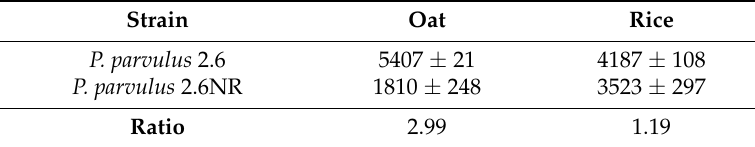
Table 2. Viscosity (cP) determined at 40 rpm for 30 s of the oat and rice products fermented for 40 h by P. parvulus 2.6 or 2.6NR strains. Three independent experiments were performed in